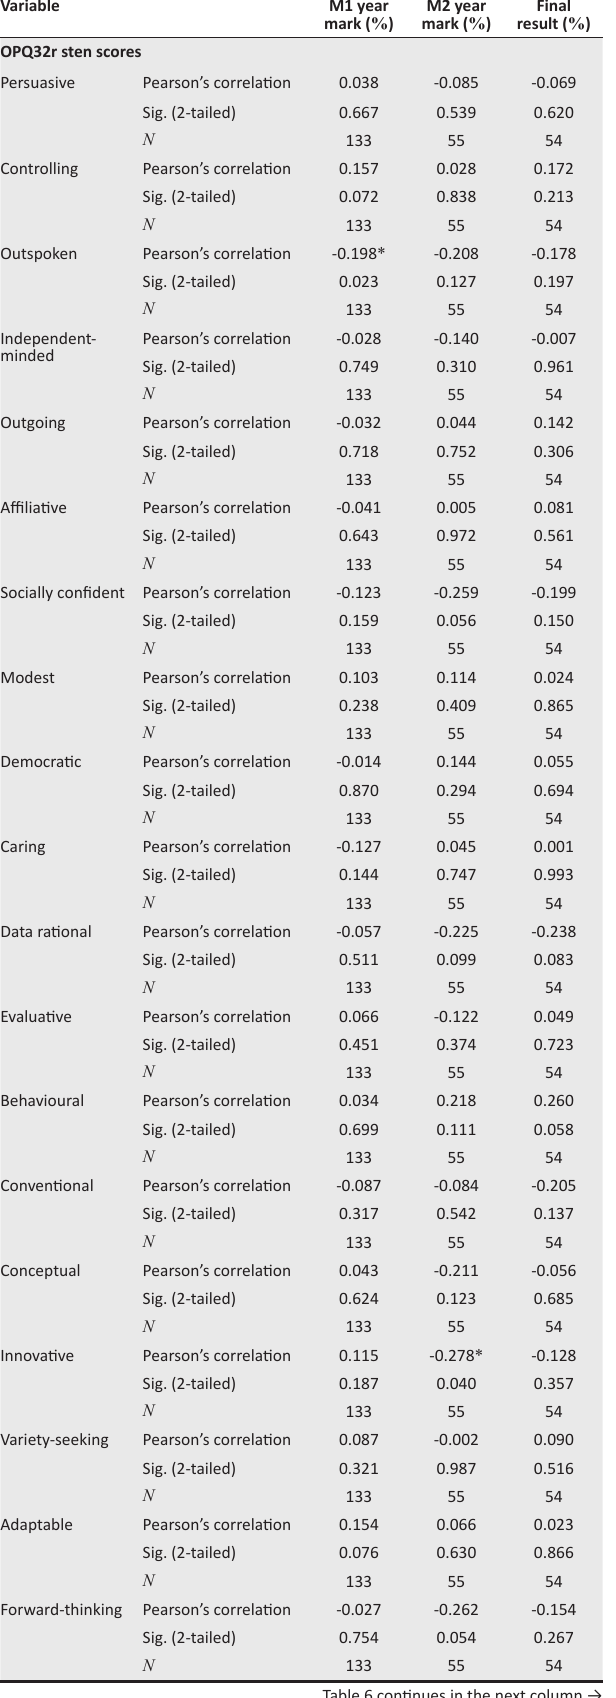
TABLE 6 (Continues...): Pearson’s correlation between academic success and the occupational personality questionnaire sten scores.